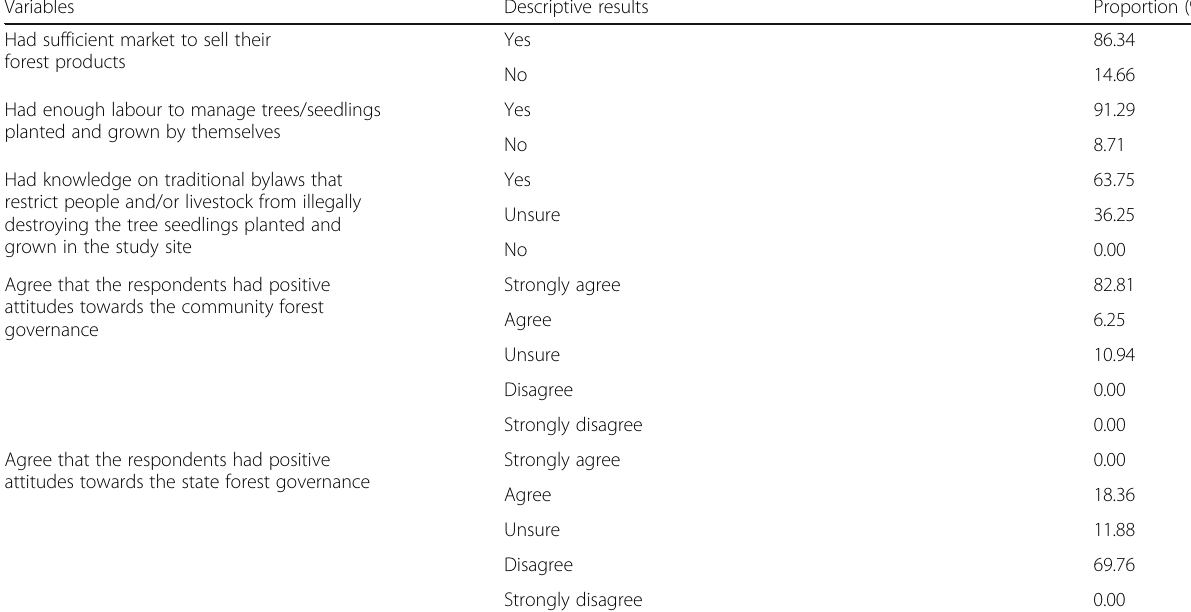
Table 1 Socioeconomic characteristics and descriptive results